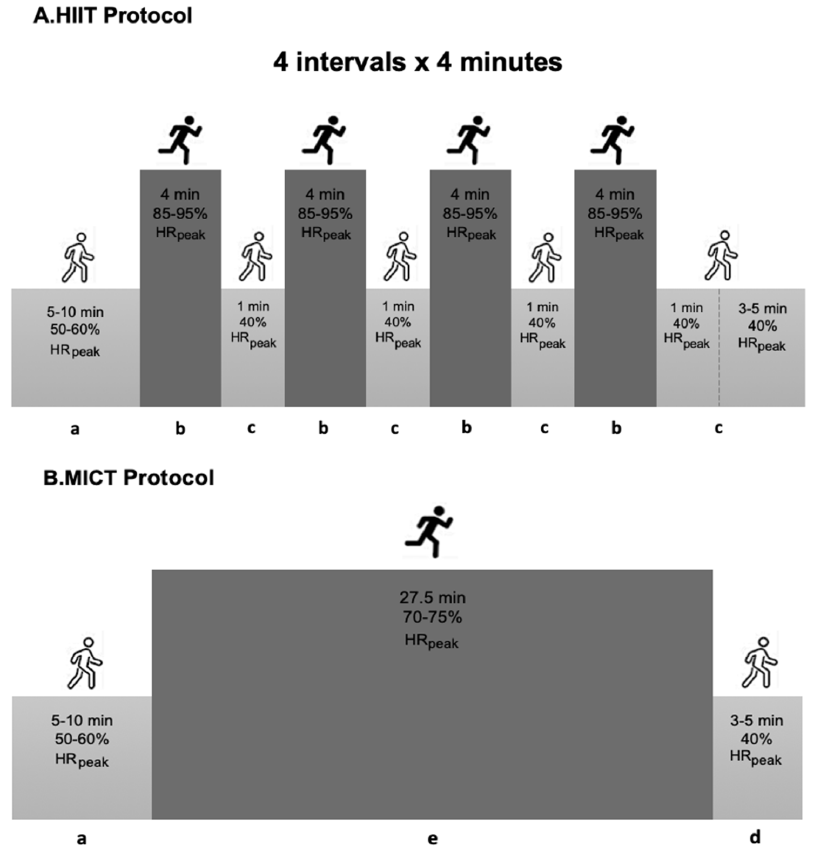
Figure 2. Summary of the exercise training protocol. HIIT—High-intensity Interval Training; MICT—Moderate-intensity Continuous Training; a—warm-up; b—interval bout of high-intensity exercise; c—one-minute recovery interval; d—cool-down; e—continuous bout of moderate-intensity exercise; min—minutes.